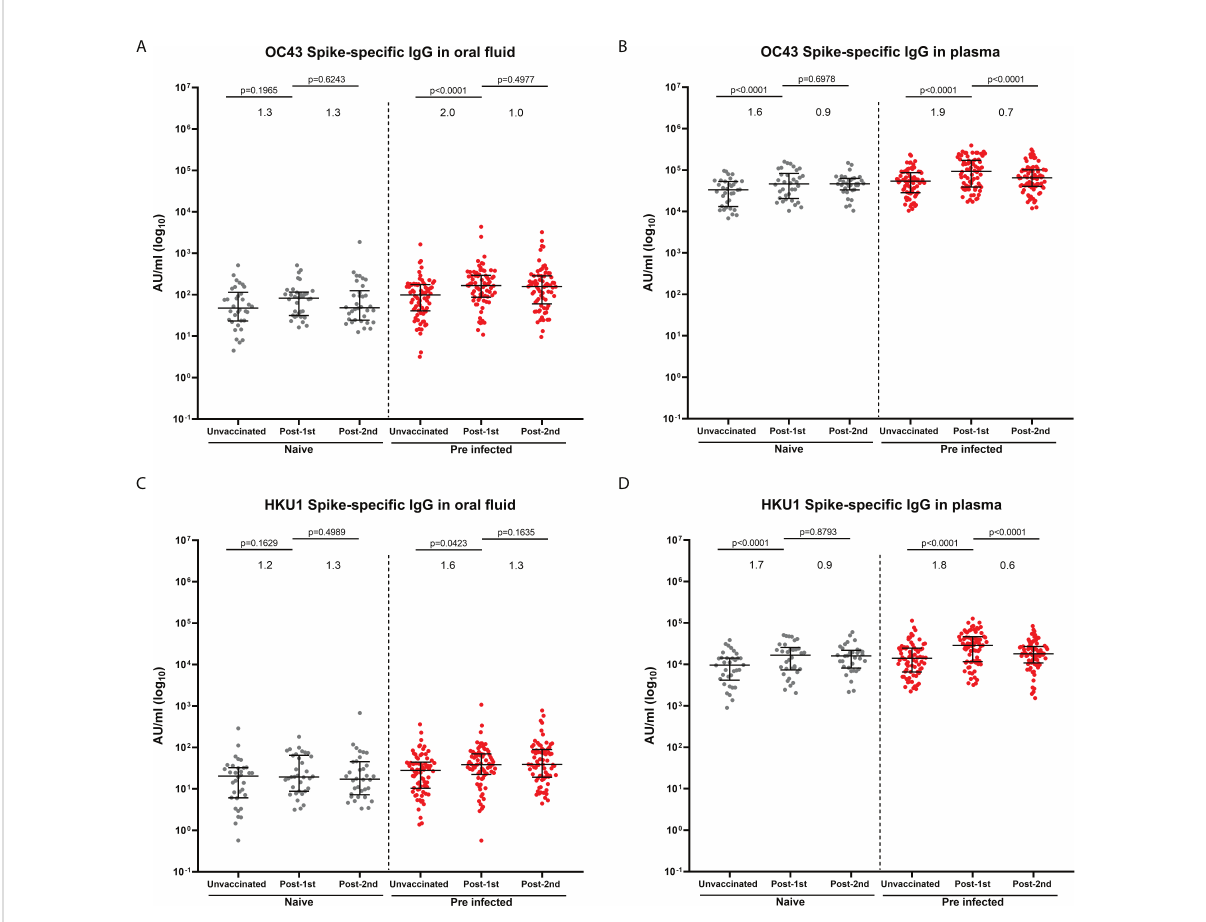
FIGURE 3 IgG responses to human seasonal beta coronaviruses in matched oral fl uid and plasma. Concentrations (AU/ml) of OC43 (A, B) and HKU1 (C, D) S-speci fi c IgG measured in oral fl uid (A, C) and plasma (B, D) from naïve and previously-infected individuals using MSD ® multiplex immunoassay. Wilcoxon rank tests were used to determine the statistical differences between paired samples. Values above the columns show the fold increases in S-speci fi c IgG levels. Matched naïve samples: N=34; Matched previously-infected samples: